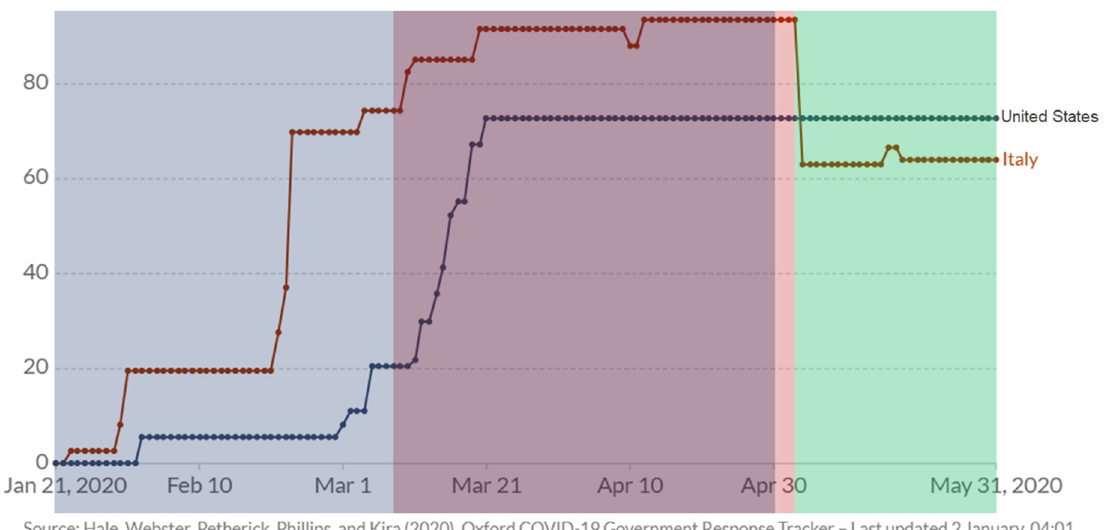
Figure 5. Evaluation of restricting policies in the U.S. and Italy during the observation periods analyzed by O’Shea et al. (blue shaded) and in our analysis (red-shaded area is the lockdown period, and the green-shaded area is the post-lockdown period). The y-axis reports a composite measure based on nine response indicators including school closures, workplace closures, and travel bans, rescaled to a value from 0 to 100 (100 = strictest) (for additional information, see https:// ourworldindata.org/grapher/covid-stringency-index?tab=chart, accessed on 2 January